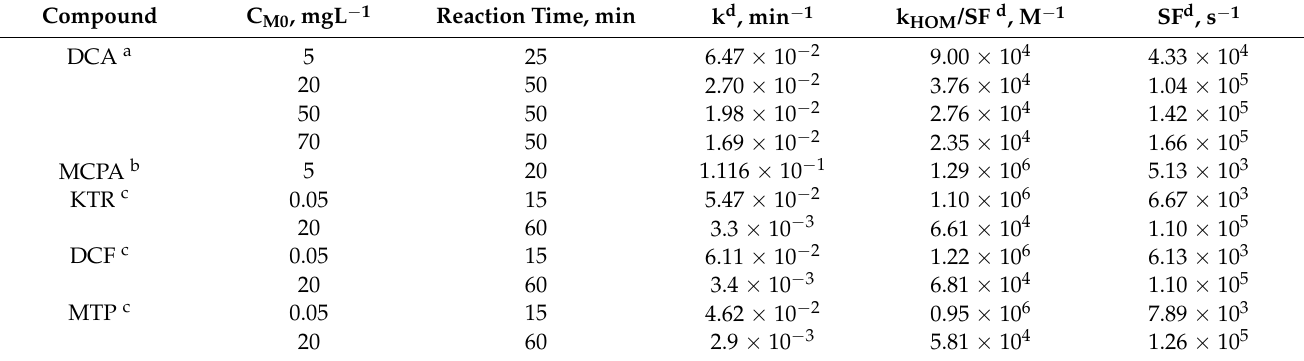
Table 2. Compounds considered, initial concentration, reaction time of first-order kinetics, first-order rate constant, intrinsic rate constant and scavenging factor.